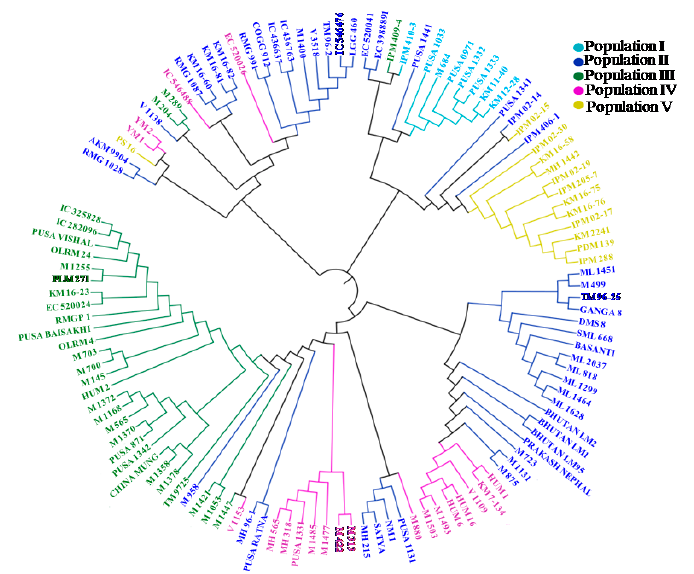
Figure 3. Phylogenetic tree constructed for mungbean association mapping panel. Genotypes cor- responding to different colors represent the five sub populations and admixture in the population.